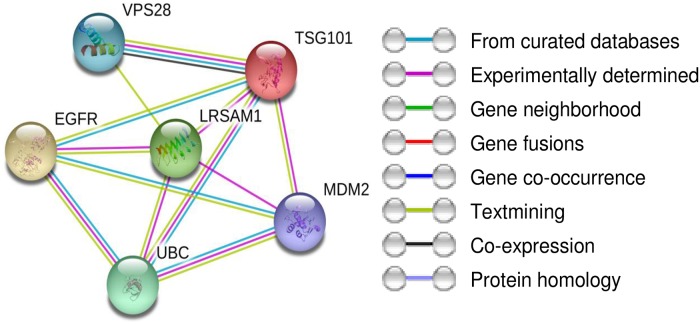
Protein–protein interaction network determined by STRING analysis for LRSAM1 protein.The interaction sources textmining, experiments, databases, co-expression, neighborhood, gene fusion and co-occurrence were used for the selection of the proteins.